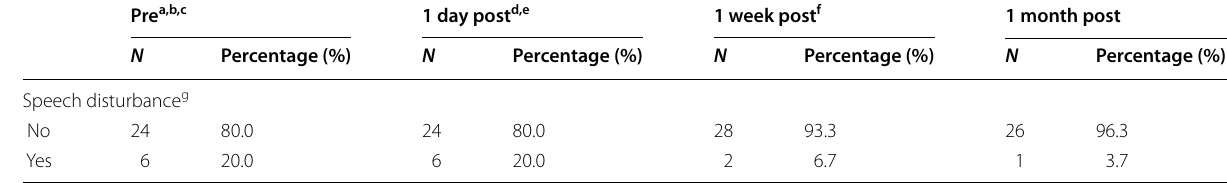
Pre, preoperatively; Post, postoperatively; N , number of patients a,b,c Pre vs. 1 day p d,e